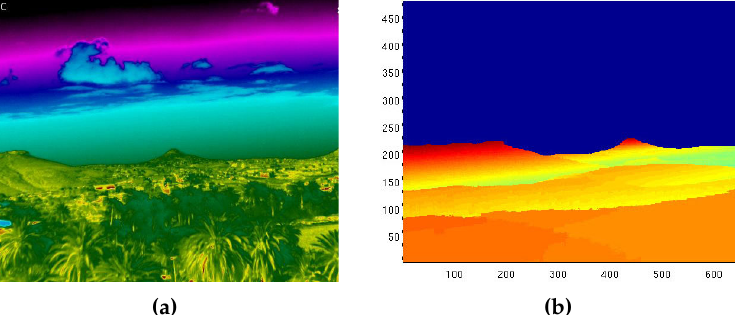
Figure 4. Synthetic image with large disalignment with respect to the thermographic Image. ( a ) Thermographic image. ( b ) Synthetic